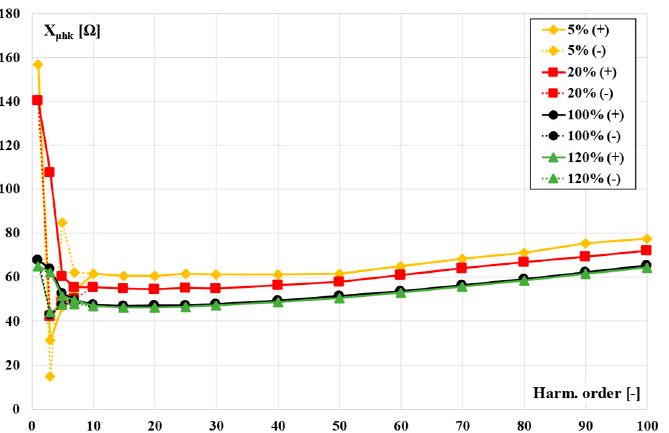
Figure 7. The change, with the frequency of the transformed harmonic, of the mutual reactance of windings of a 100A/5A